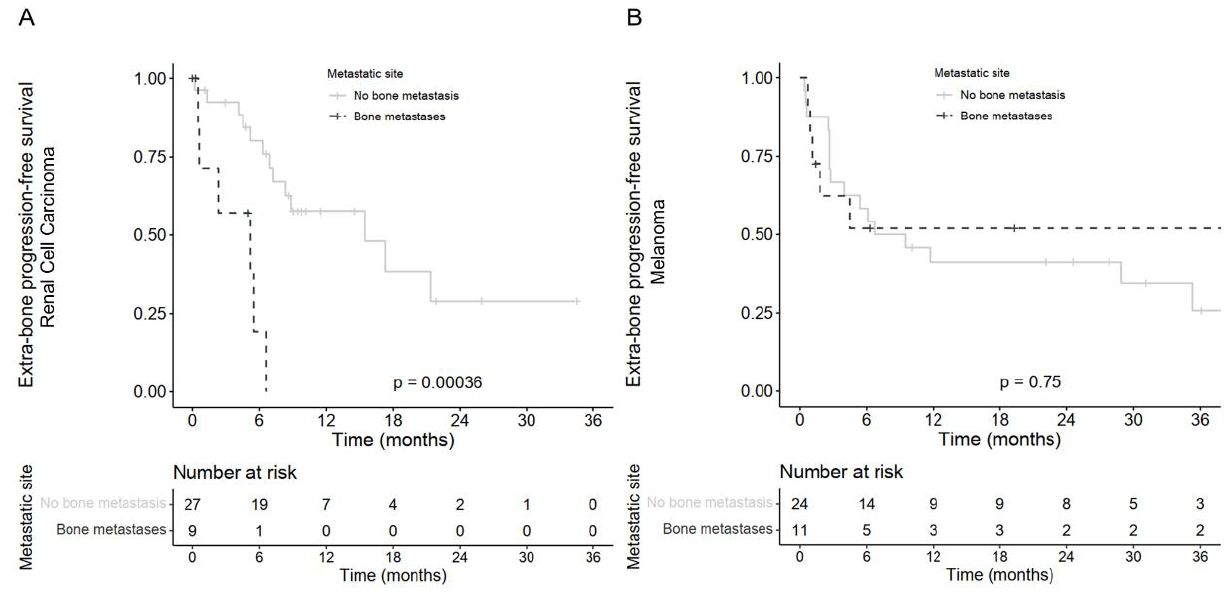
Figure 2. Kaplan–Meier estimates of the extra-bone progression-free survival according to bone metastases for patients treated with ipilimumab plus nivolumab ( A ) in patients with renal cell carcinoma and ( B ) in patients with melanoma.